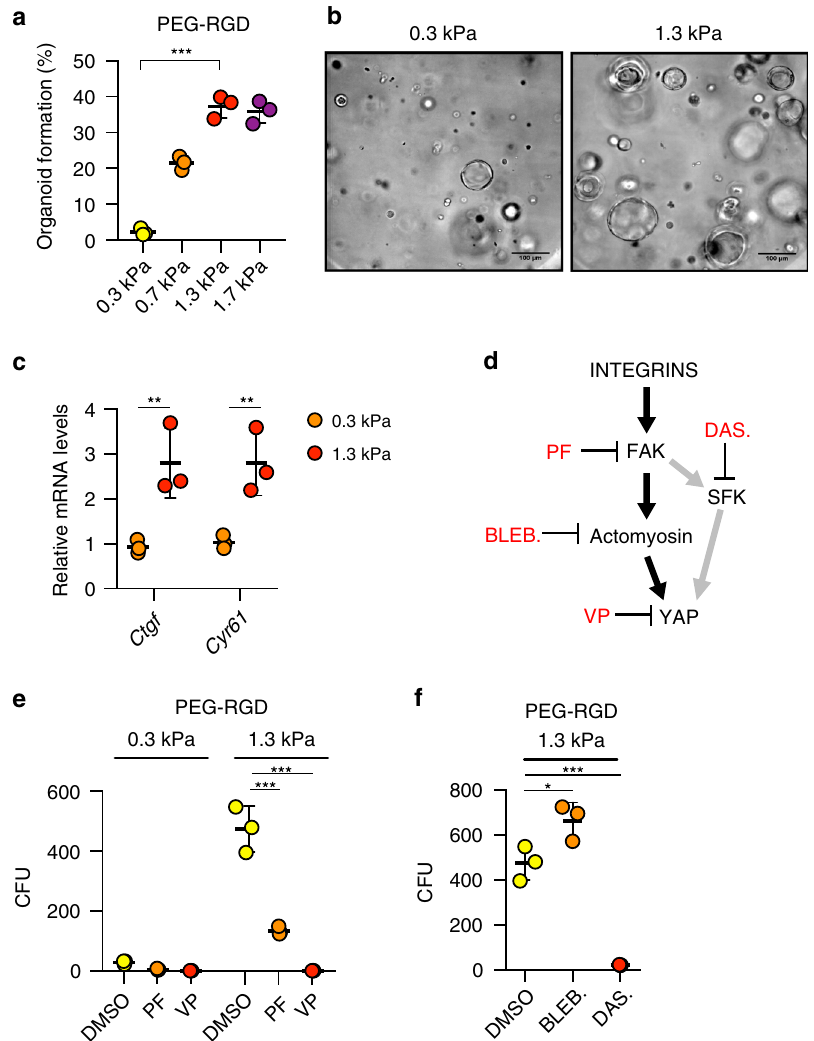
Fig. 3 Effect of matrix stiffness on liver organoid formation. a Effect of matrix stiffness on organoid formation ef fi ciency. Graphs show individual data points derived from n = 3 independent experiments and means±s.d. ( P <0.0001). b Representative image of organoids 3 days after embedding in PEG-RGD hydrogels of indicated stiffness. c Gene expression was analysed by qRT-PCR in liver organoids 6 days after embedding in PEG-RGD hydrogels with indicated stiffness. Graphs show individual data points derived from n = 3 independent experiments and means±s.d. ( P = 0.0088; 0.0077). d Schematic representation of cellular mechano-signalling pathways. Inhibitors of key elements are depicted in red. e Effect of indicated inhibitors on organoid formation ef fi ciency in soft (300Pa) and physiologically stiff (1.3 kPa) PEG-RGD hydrogels. CFU (colony forming unit). Graphs show individual data points derived from n = 3 independent experiments and means±s.d. ( P <0.0001). f Effect of indicated inhibitors on organoid formation ef fi ciency in physiologically stiff (1.3 kPa) PEG-RGD hydrogels. CFU (colony forming unit). Graphs show individual data points derived from n = 3 independent experiments and means±s.d. ( P = 0.0198; 0.0003). * P <0.05, ** P <0.01, *** P <0.001 one-way Anova ( a , f ) or two-way Anova ( c , e ). Source data are provided as a Source Data fi